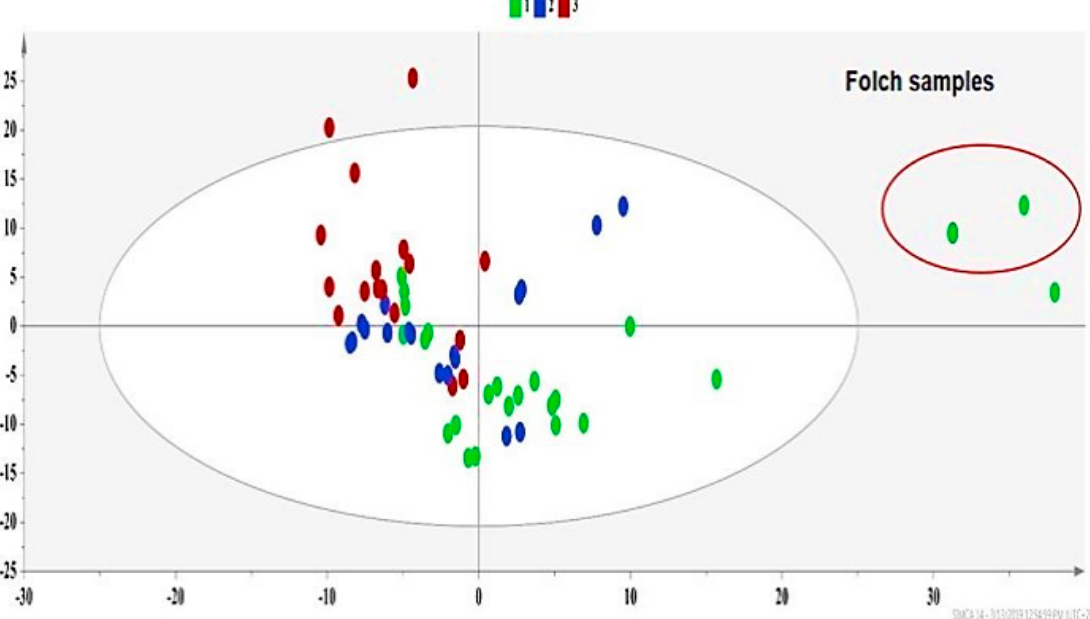
Figure 6. PCA of experimental design (DOE)-extracts PCA-X, where A = 2, N = 57, R 2 X(cum) = 0.73, Q 2 (cum) = 0.57, green dots = apricot pulp samples with a low extraction yield ( ≤ 5 mg carotenoids 100 g − 1 dry sample), blue dots = apricot pulp samples with a medium extraction yield (5–15 mg carotenoids 100 g − 1 dry sample), and red dots = apricot pulp samples with a high extraction yield ( ≥ 15 mg carotenoids 100 g − 1 dry sample).